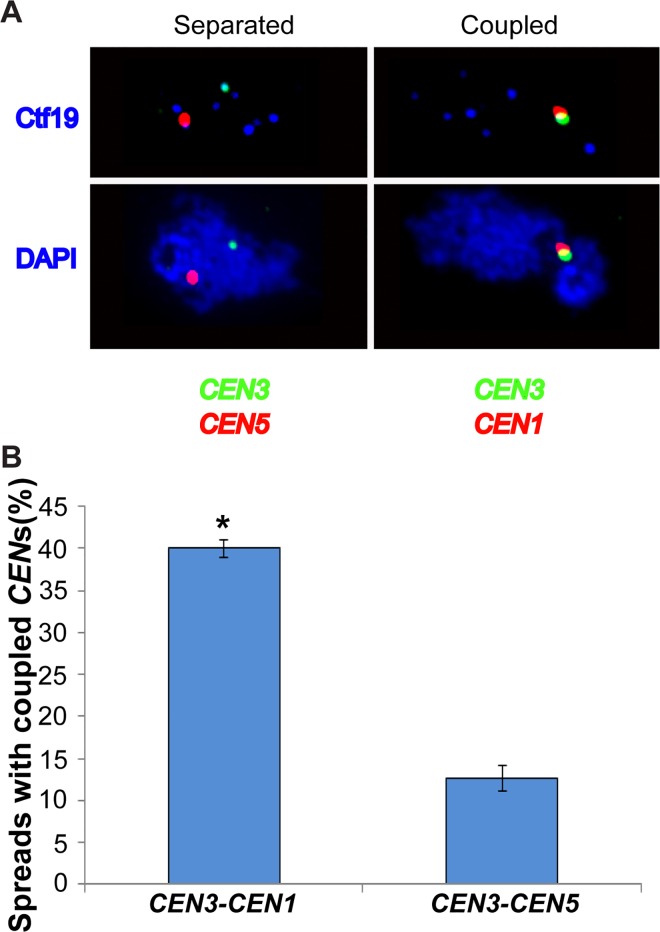
Cytological demonstration of differential coupling from 3C2D-qPCR data.(A) Representations of two spread nuclei (from spo11 haploid strains) in the coupling phase of meiosis. Left: centromeres 3 and 5 are separated (not coupled). Right: centromeres 1 and 3 are coupled. Upper: Red focus is centromere 5 or 1, green focus is centromere 3, and blue foci indicate kinetochores (Ctf19). Lower panels, same as above, but blue marks DNA (DAPI). (B)
spo11 haploids containing two centromeres marked with GFP-CEN3 and either mCherry-CEN1 (BR5890) or mCherry-CEN5 (BR5891) were scored for centromere coupling (overlap of red and green signals) in three independent experiments (see Methods for details). The percentage of spreads with coupled CENs is given on the y-axis (mean +/- standard deviation). The asterisk indicates statistical significance (P < 0.01). P-value was calculated using Fisher’s Exact Test (in this case, P < 10−7).